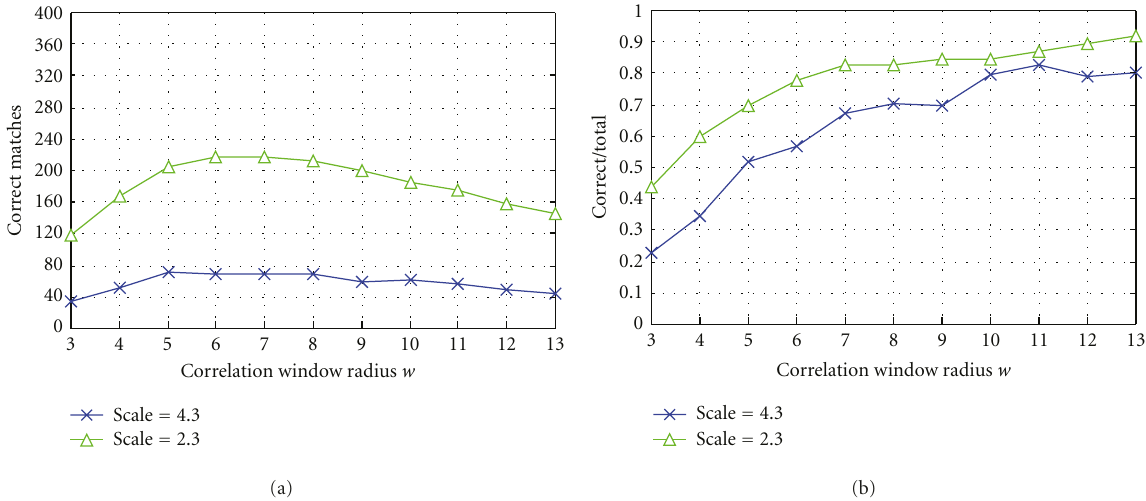
Figure 6: The evaluation for di ff erent correlation window radiuses. (a) This graph shows the number of correct matches as a function of radius of the correlation window under di ff erent scale changes. (b) This graph shows the ratio of correct matches to total matches as a function of radius of the correlation window under di ff erent scale changes. The results are obtained from images in “Boat” sequence (frame 0, 5, and 9). The scale change between frames 0 and 5 is 2.3, and the rotation angle is about 9 degrees. The scale change between frames 0 and 9 is 4.3, and the rotation angle is about 45 degrees.